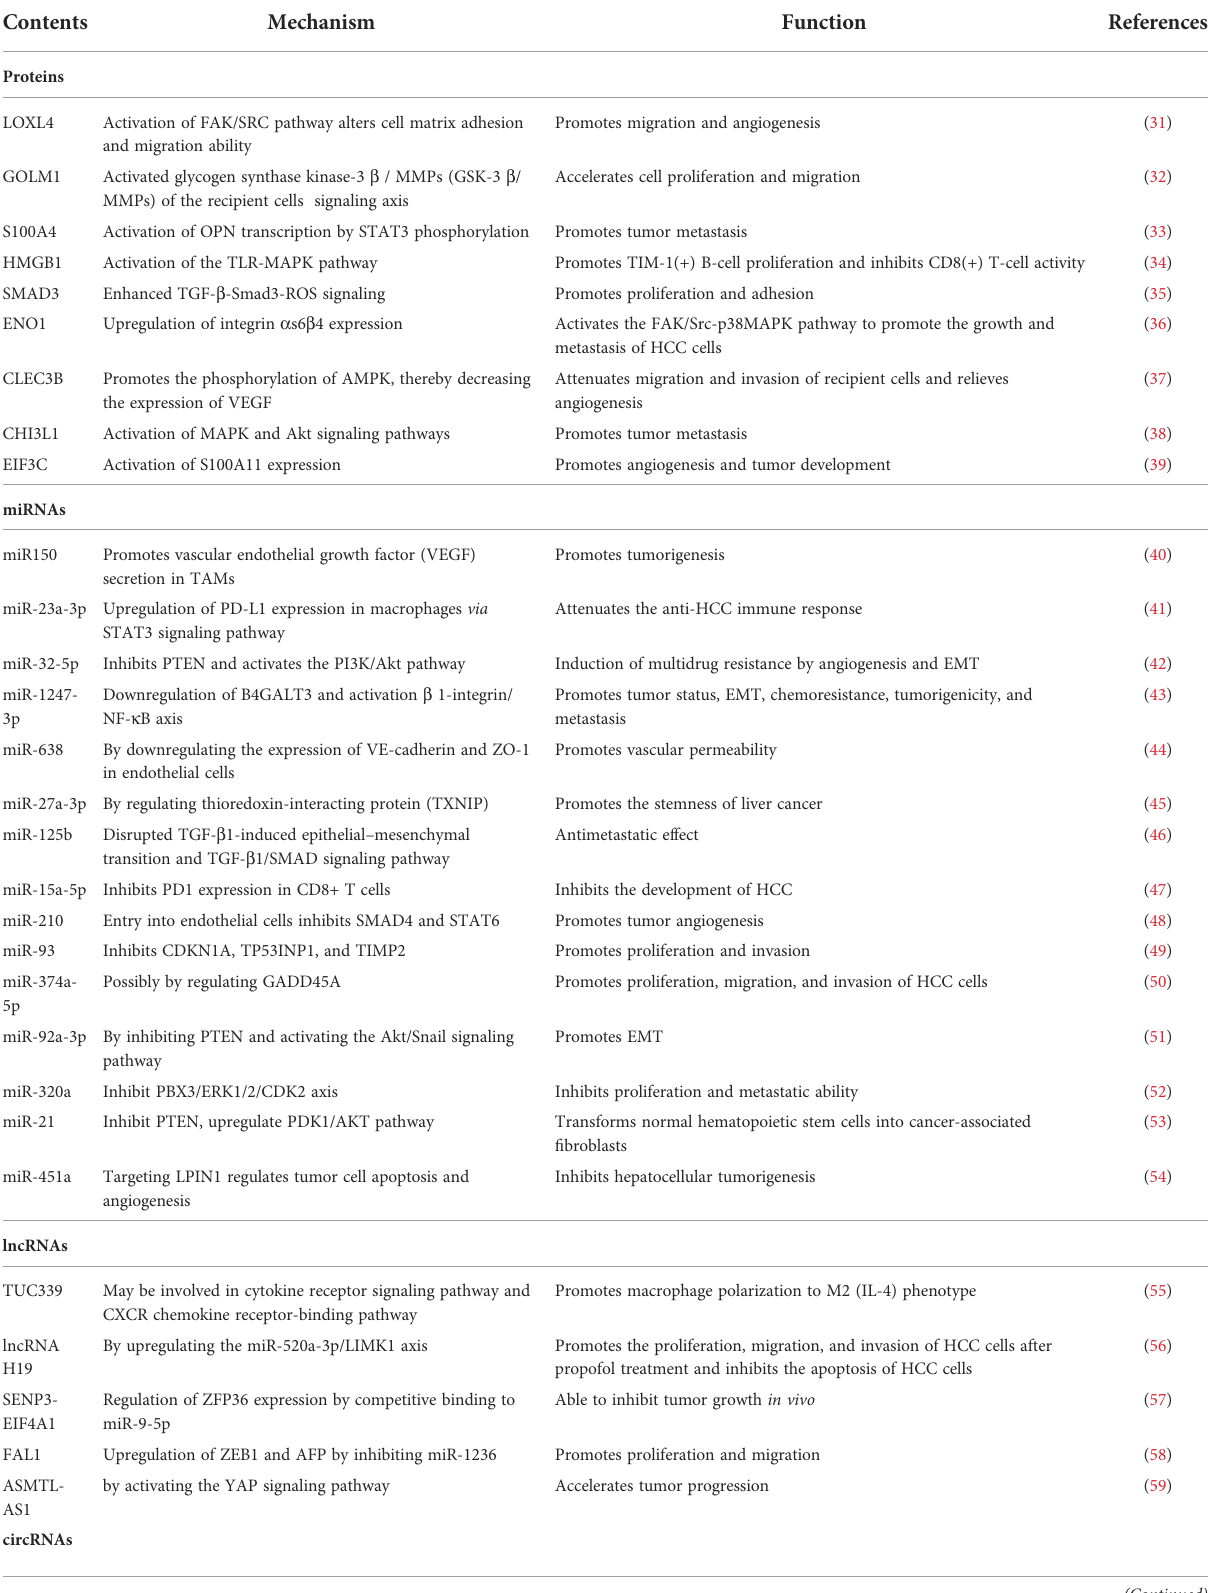
TABLE 1 Effects of exosome contents on hepatocellular